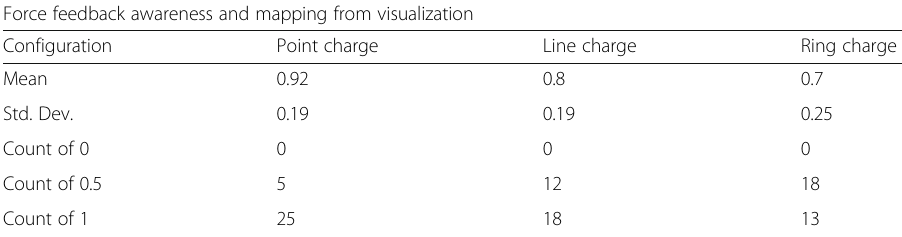
Table 5 Descriptive statistics of student performance on the laboratory report Force feedback awareness and mapping from visualization Configuration Point charge Line charge Ring charge Mean 0.92 0.8 0.7 Std. Dev.